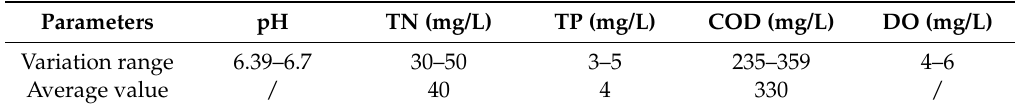
Table 1. The quality of wastewater.